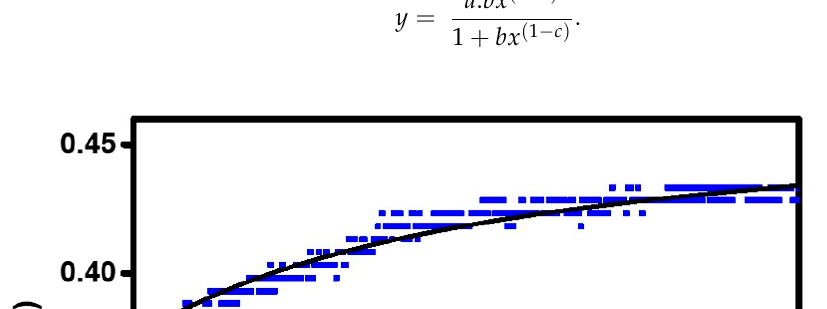
Table 2. The pDNA adsorption kinetic variables measured in different electrolytes.